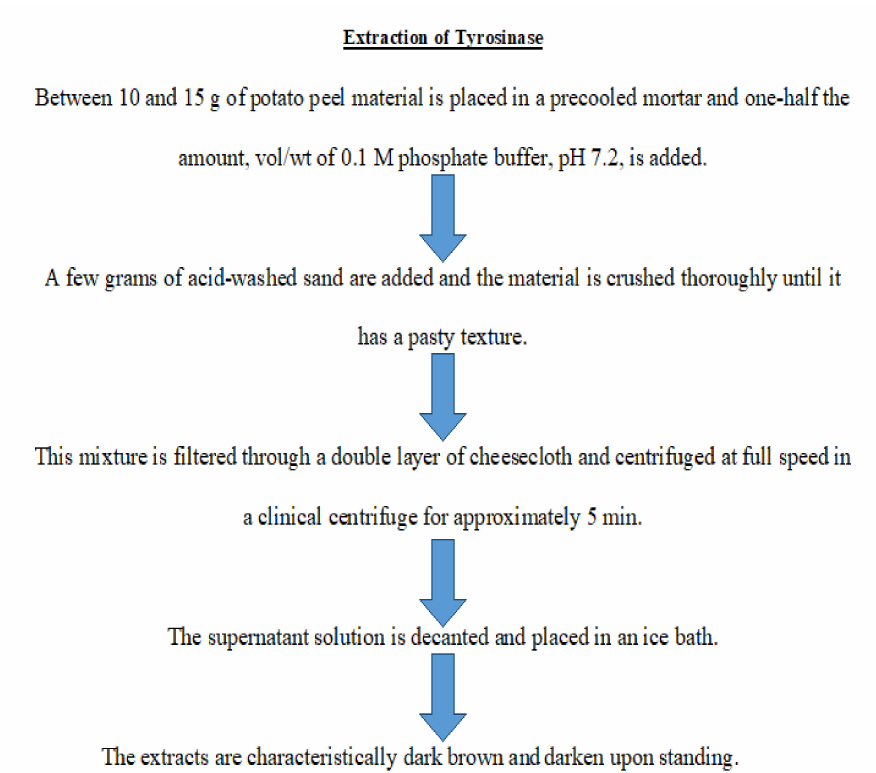
Figure 1. Flowchart for the preparation of potato peel tyrosinase